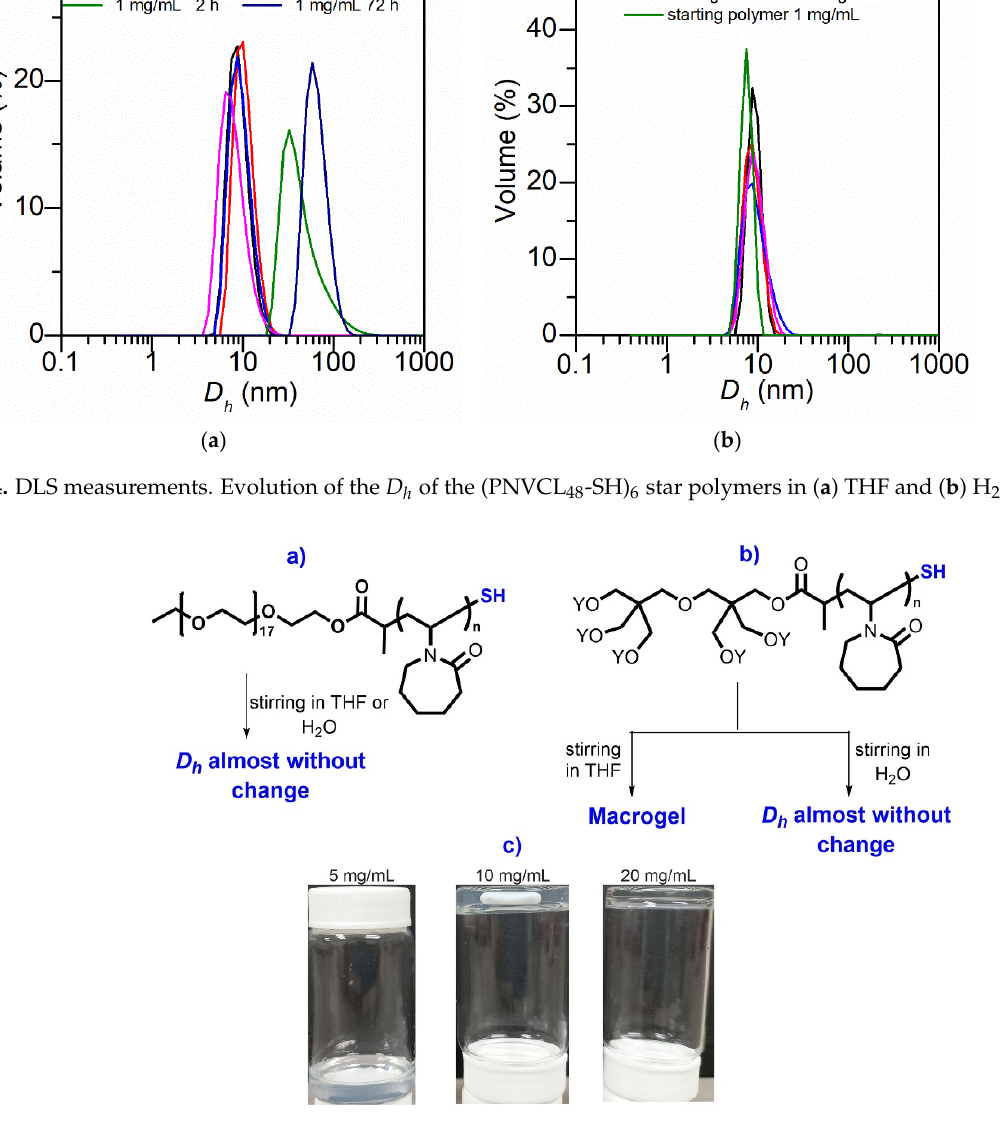
Scheme 3. Behavior of ( a ) linear PNVCL-SH solution and ( b ) six-arm (PNVCL-SH) 6 star polymers